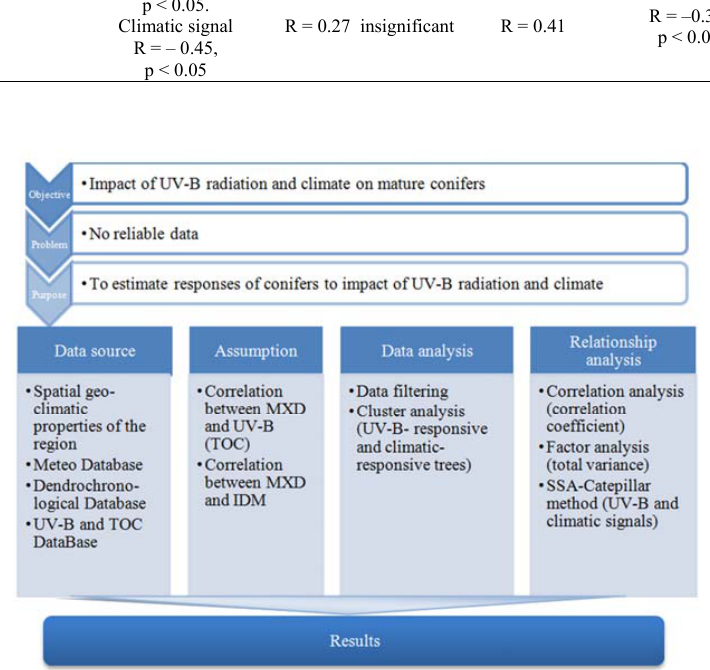
Fig.11: A block diagram illustrating the developed method